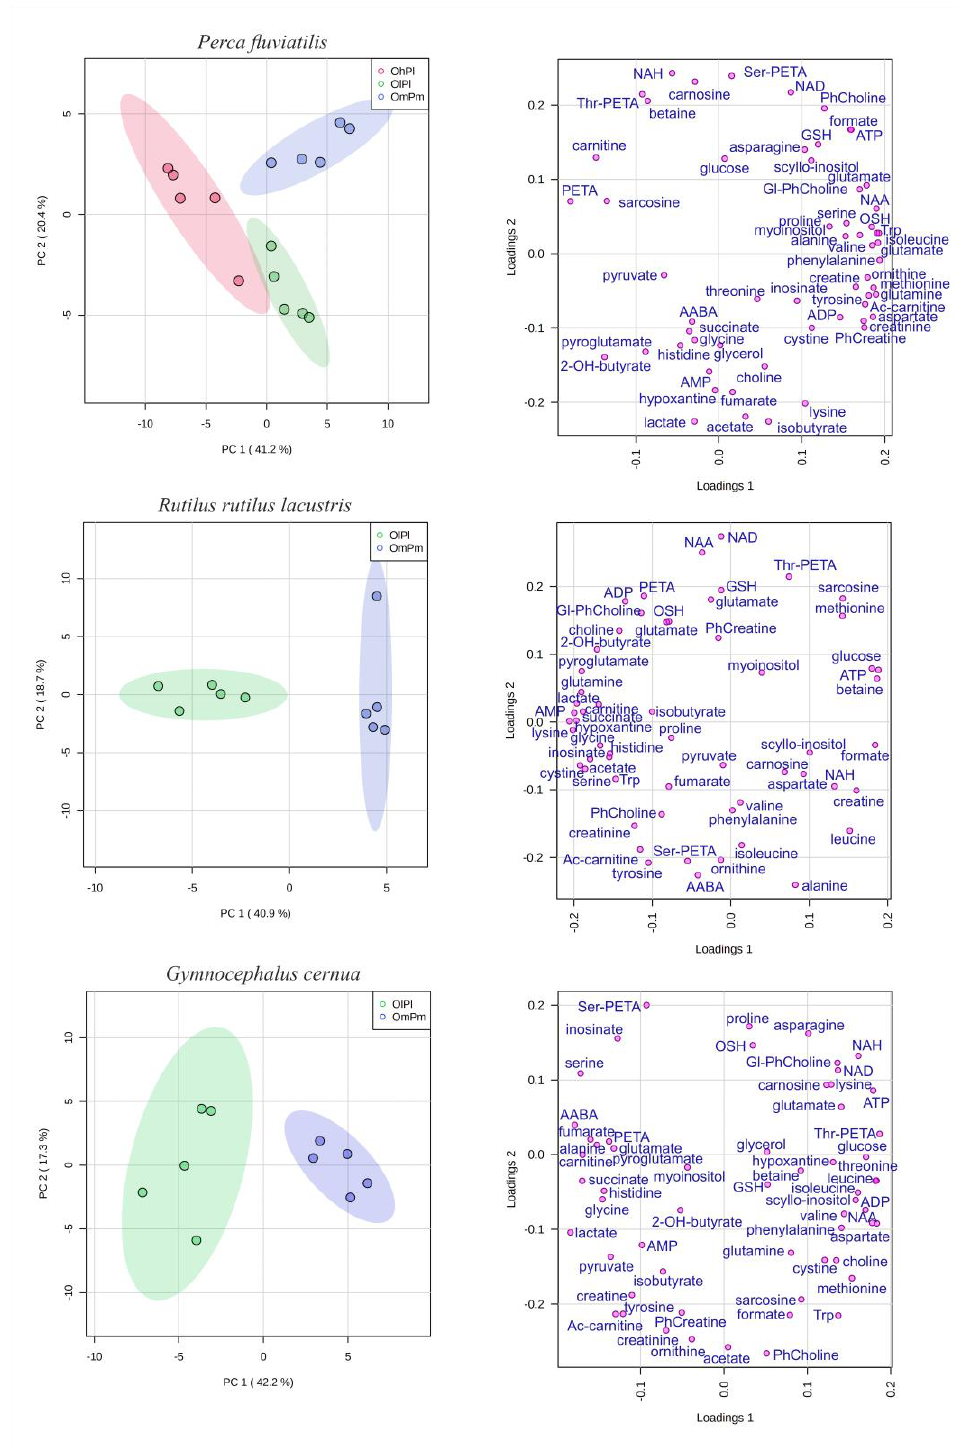
Figure 1. Score ( left ) and loading ( right ) plots of principal component analysis (PCA) of lens metabolomic profiles of P. fluviatilis (upper graphs), R. rutilus lacustris (middle graphs), and G. cernua (lower graphs) caught in the Nigiya River (green, OlPl), Lake Borovoye (red, OhPl), and the Ob Reservoir (blue, OmPm). The data are autoscaled. Colored ovals indicate 95% confidence regions. Variance explained by the first (PC1) and second (PC2) principal components are indicated on the